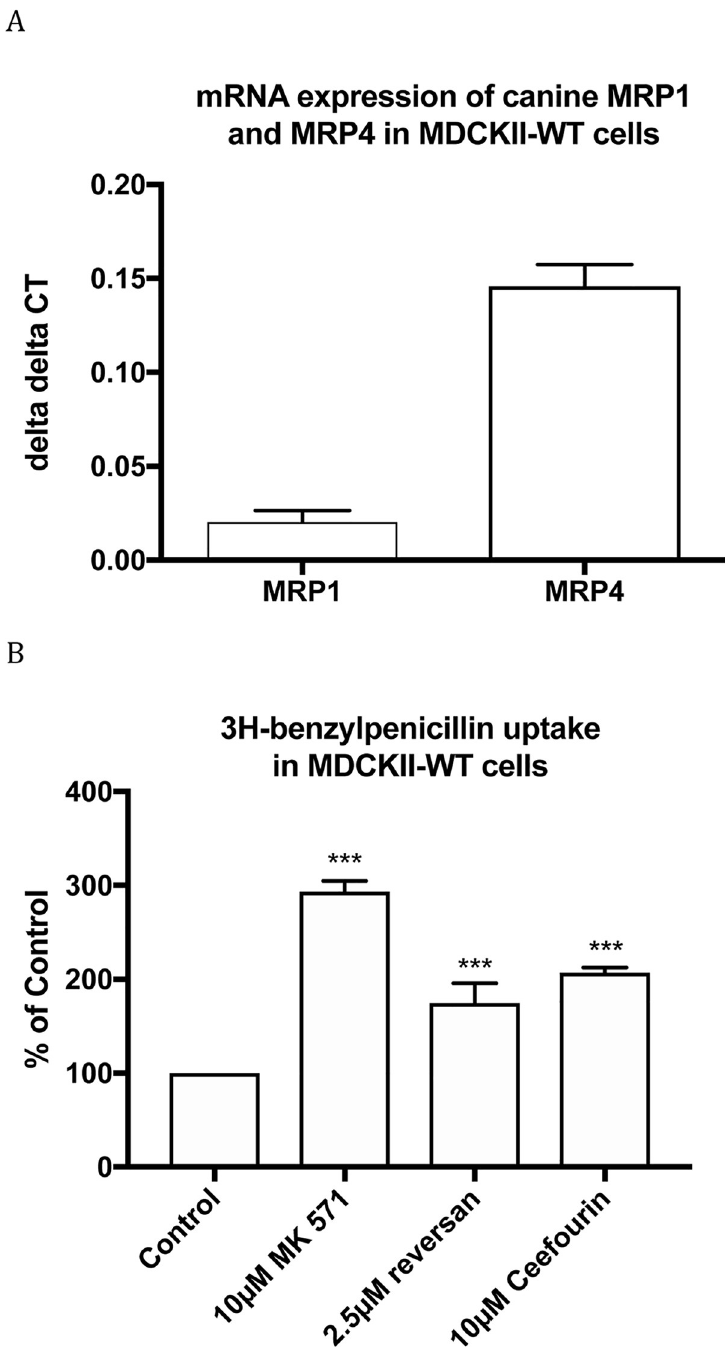
Fig 1. mRNA expression of MRP transporters in MDCKII-WT cells (A) and [ 3 H]benzylpenicillin uptake in MDCKII-WT cells with and without inhibitors (B). Values are means +/- S.E., n = 3, each performed in triplicate. ��� indicate significant differences from comparison between different cells at the P < 0.001